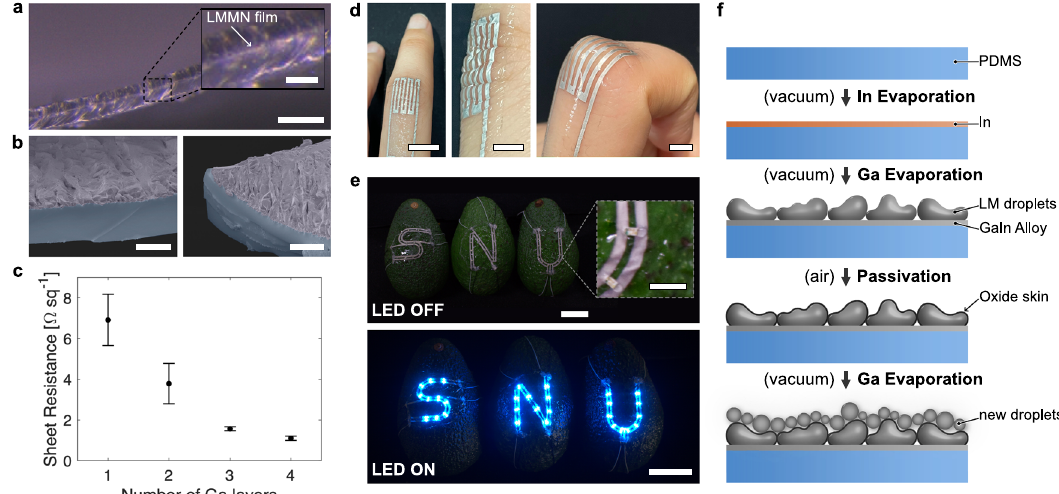
Fig. 1 LMMN fi lms prepared with the LBL deposition method. a A cross-sectional optical micrograph of an LMMN fi lm embedded inside a PDMS substrate with 50 μ m thickness (scale bar: 100 µm; inset image scale bar: 30 µm). b False-color scanning electron microscopy (SEM) images of LMMN fi lms on an ultrathin PDMS substrate (scale bars: 25 µm). Blue indicates the PDMS substrate, and violet indicates LMMN fi lms. c Sheet resistances of LMMN fi lms with different numbers of LBL-deposited gallium layers. The thickness of each layer was fi xed, and the total thickness of the fi lm varies depending on the number of gallium layers. Data were measured from 1 × LBL to 4 × LBL ( n = 4 samples, error bars: standard deviation.). d Photographs of a resistive fi nger fl exion sensor attached to a fi nger: Top view (scale bar: 10 mm), side view (scale bar: 5 mm), and under proximal interphalangeal (PIP) joint fl exion (scale bar: 5 mm) from left to right. e Photographs of LED-embedded circuit boards patterned in “ S, ” “ N, ” and “ U ” shapes (scale bars: 3 cm; inset image scale bar: 4 mm). The circuit boards are laminated onto three avocados. f Schematic illustration of the LBL deposition for the fabrication of LM microstructures that form LMMN fi